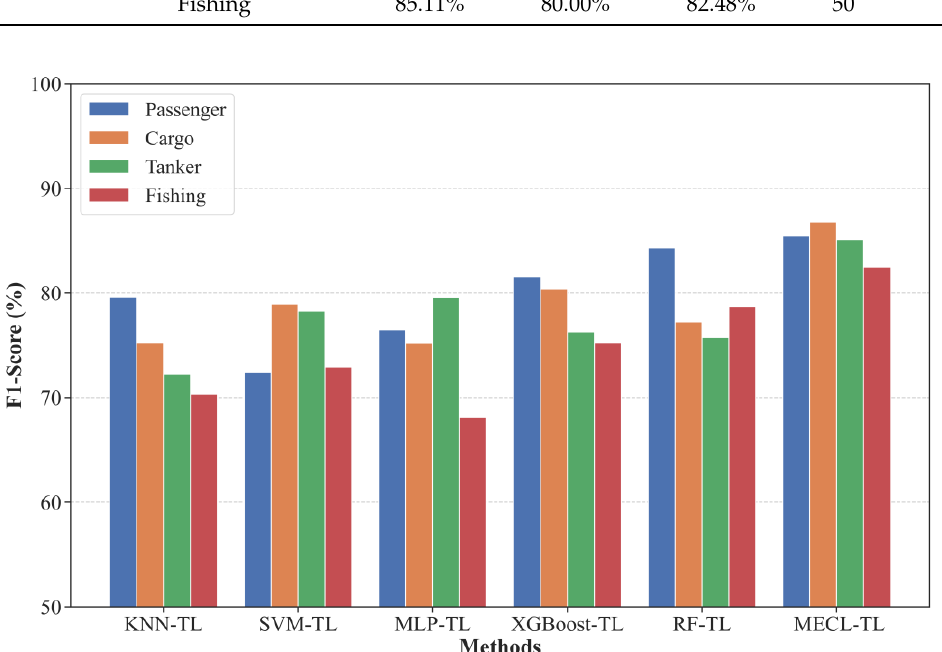
Figure 14. The F 1 -Score of each ship classification method on the SAR test